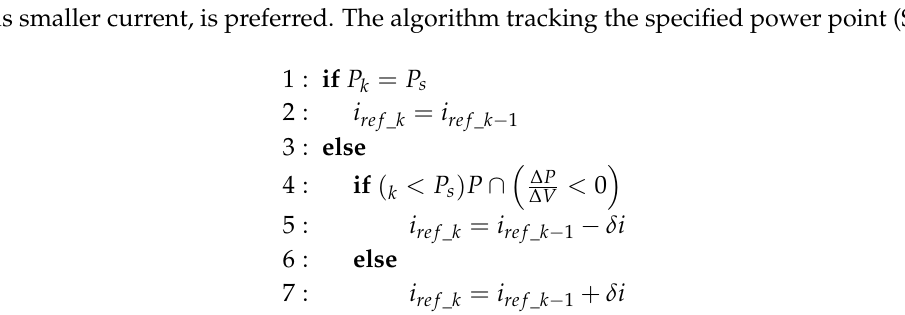
Figure 7. Characteristic PV and SPPT control curves.